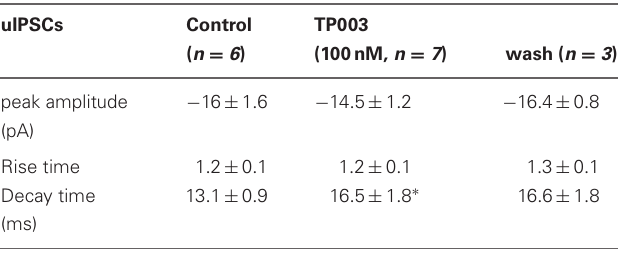
Table 3 | Effects of TP003 (100nM) on uIPSCs recorded from Imp paired recordings experiments.